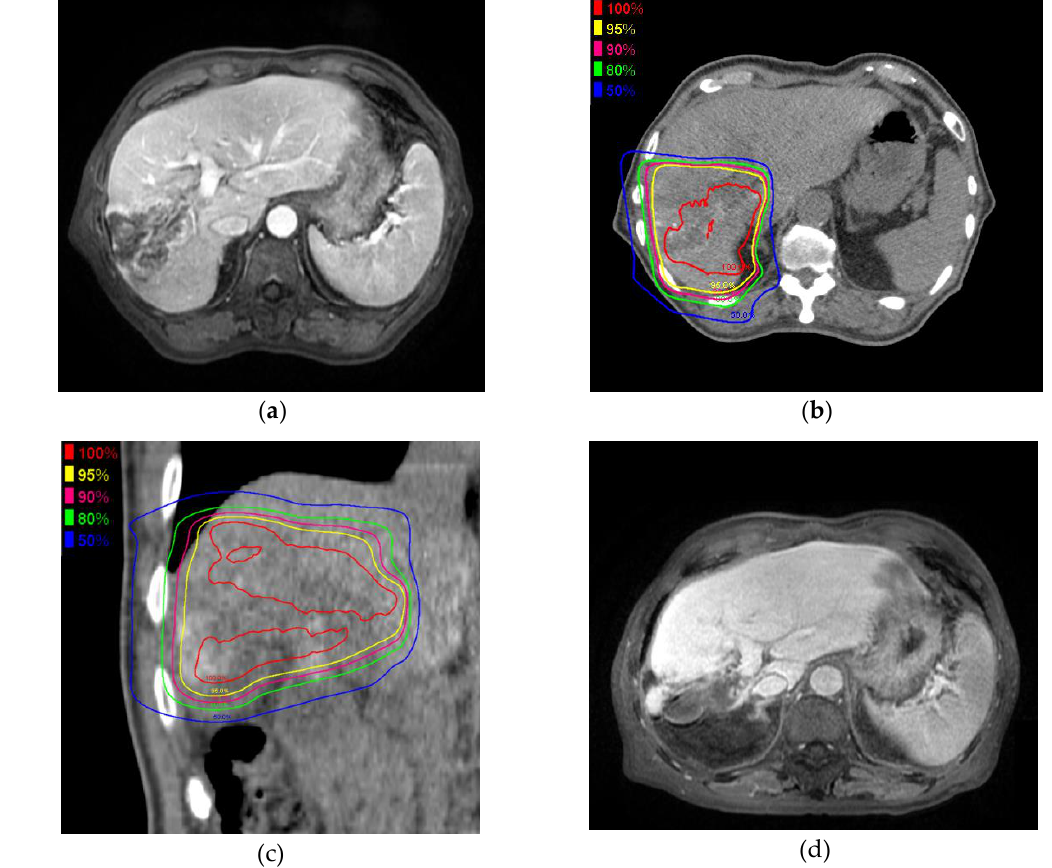
Figure 2. A 6.3 cm hepatocellular carcinoma (HCC) was treated by proton beam therapy (PBT) in a patient with Child – Pugh class A liver disease and right portal vein tumor thrombosis. ( a ) Early enhancement of the HCC was shown in the arterial phase of gadolinium ethoxybenzyl diethylenetriamine pentaacetic acid-enhanced dynamic magnetic resonance imaging (Gd-EOB-MRI); ( b ) The isodose lines were shown on planning CT (axial view); ( c ) This tumor was close to the colon (coronal view); ( d ) HCC was shown in the arterial phase of EOB-MRI 2 years after PBT.